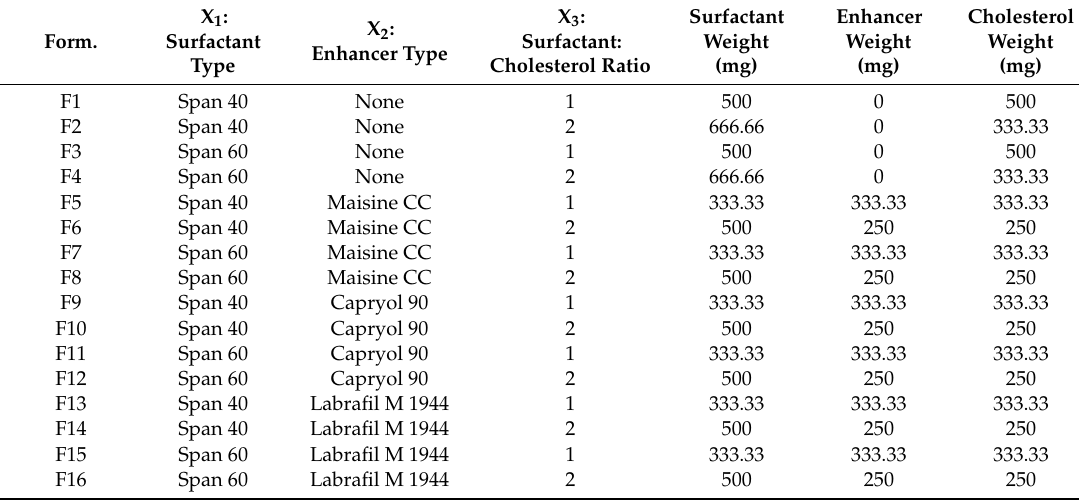
Table 1. The composition of the prepared Fexofenadine (FEX) enhanced in situ forming vesicles (EIFV) powder